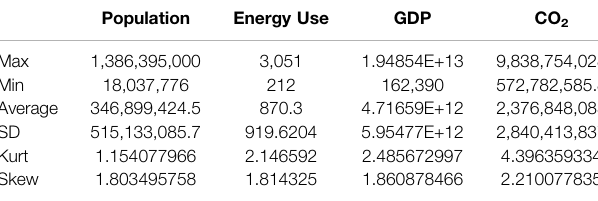
TABLE 6 | Descriptive